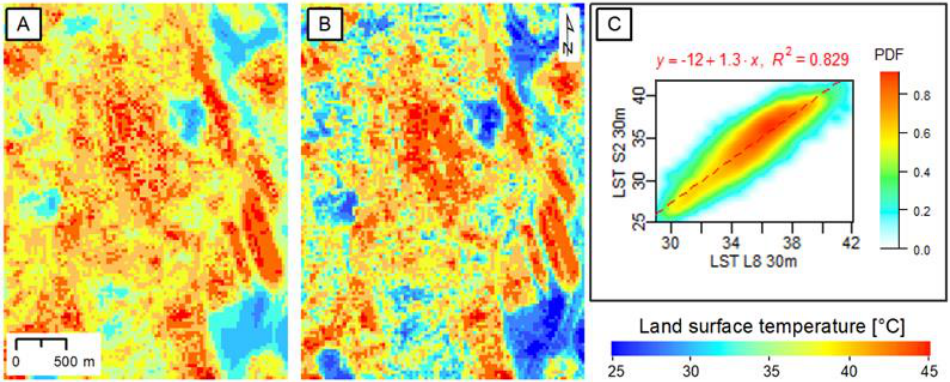
Figure 9. LST derived for the study area in Košice located on Figure 1 ( A ) from Landsat 8 LST data at 30 m resolution (L8-LST 30 m); ( B ) downscaled LST at 30 m resolution with residuals (S2-LST 30 m); ( C ) corresponding scatter plot for L8-LST 30 m and S2-LST 30 m with residuals.